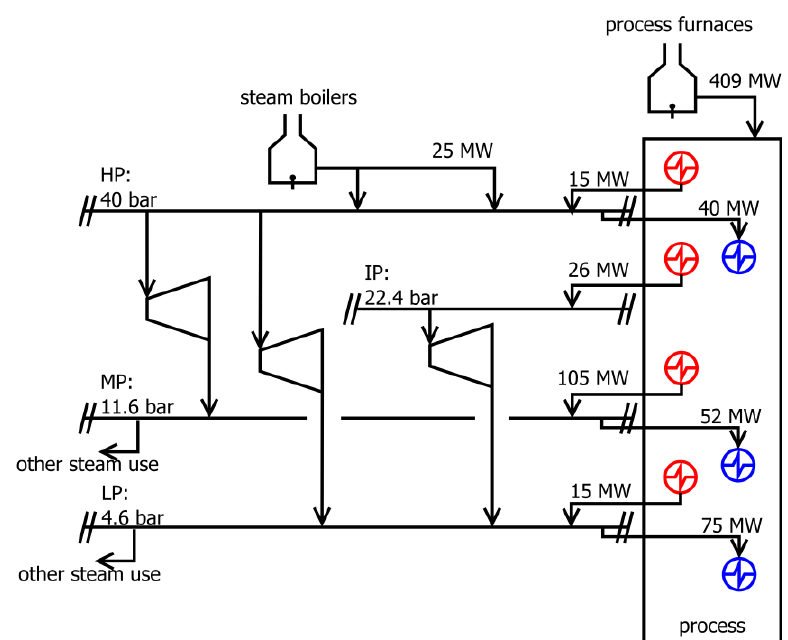
Figure 3. Simplified layout of the steam utility system. Let down valves, steam drums, desuperheaters and other miscellaneous equipment are not shown. Red symbols indicate steam generation in process coolers, neglecting those used only for feed water heating and steam superheating. Blue symbols indicate process steam heaters. Indicated steam flows are rough estimates corresponding to current operation.